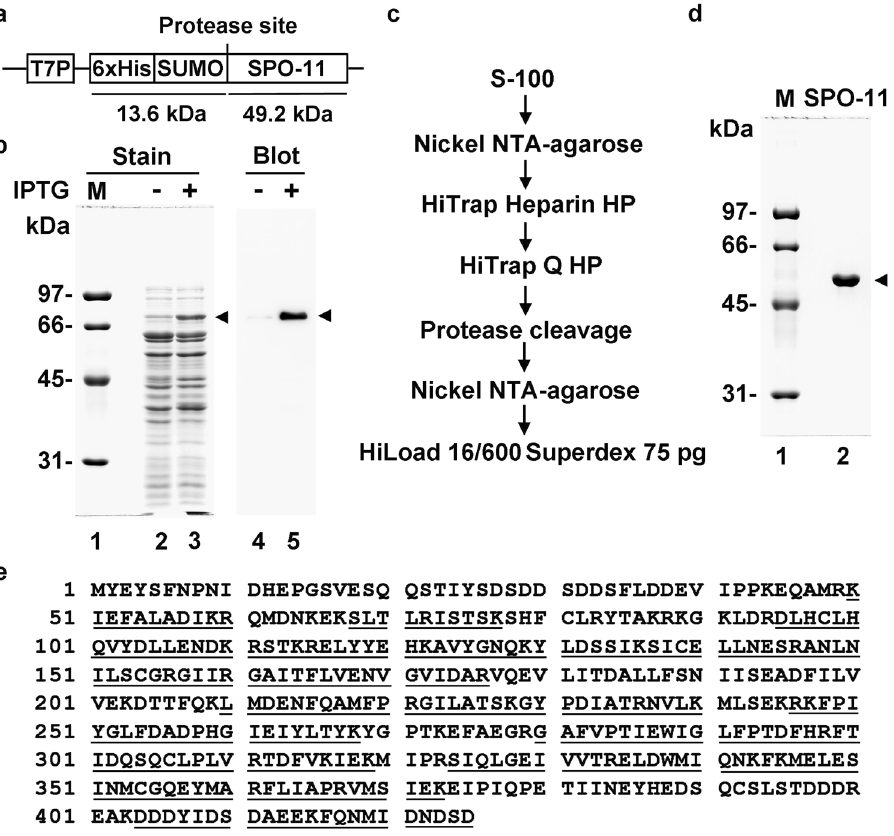
Figure 1. Expression and purification of C. elegans SPO-11. ( a ) The SPO-11 expression vector. ( b ) Extracts from E. coli cells harboring the SPO-11 expression plasmid grown with or without IPTG were analyzed by 10% SDS-PAGE and stained with Coomassie Blue or Western blot analysis with anti-His antibody. ( c ) Flow chart of SPO-11 purification. ( d ) Purified SPO-11 (1.5 μ g) was analyzed by SDS-PAGE. ( e ) Results from MALDI-TOF analysis of purified SPO-11. Identified fragments are